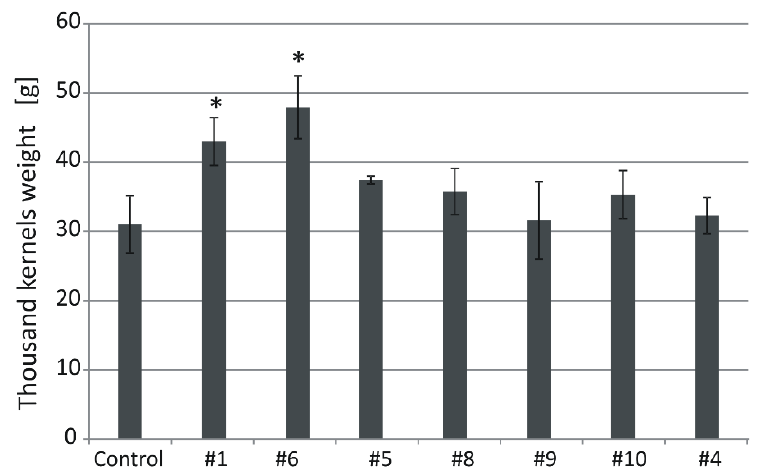
Figure 6. Thousand kernels weight (TKW) in the non-transgenic control and the transgenic plants grown in soil in normal conditions. Data represent mean values and standard deviation. Indicated are significant differences (* p < 0.05) between the control and the tested lines.